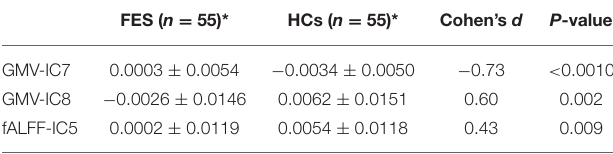
* Data are mixing coefficients, expressed as the mean ± standard deviation. FES, patients with first-episode schizophrenia; HCs, healthy controls; GMV, gray matter volume; IC, independent component; fALFF, fractional amplitude of low-frequency